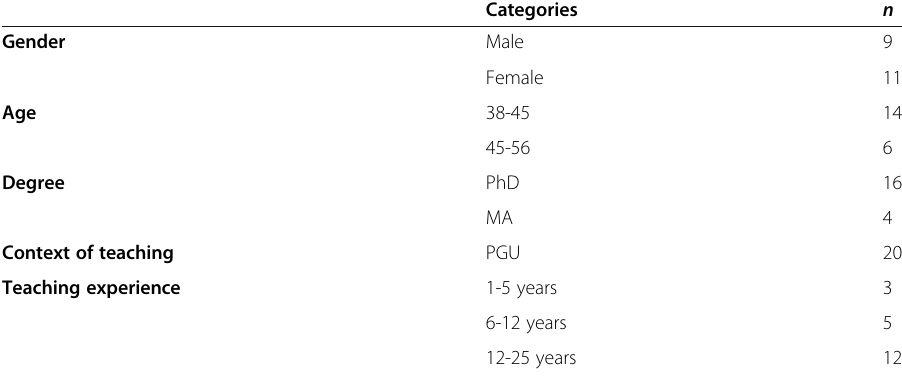
Table 1 Demographics of the participants in the